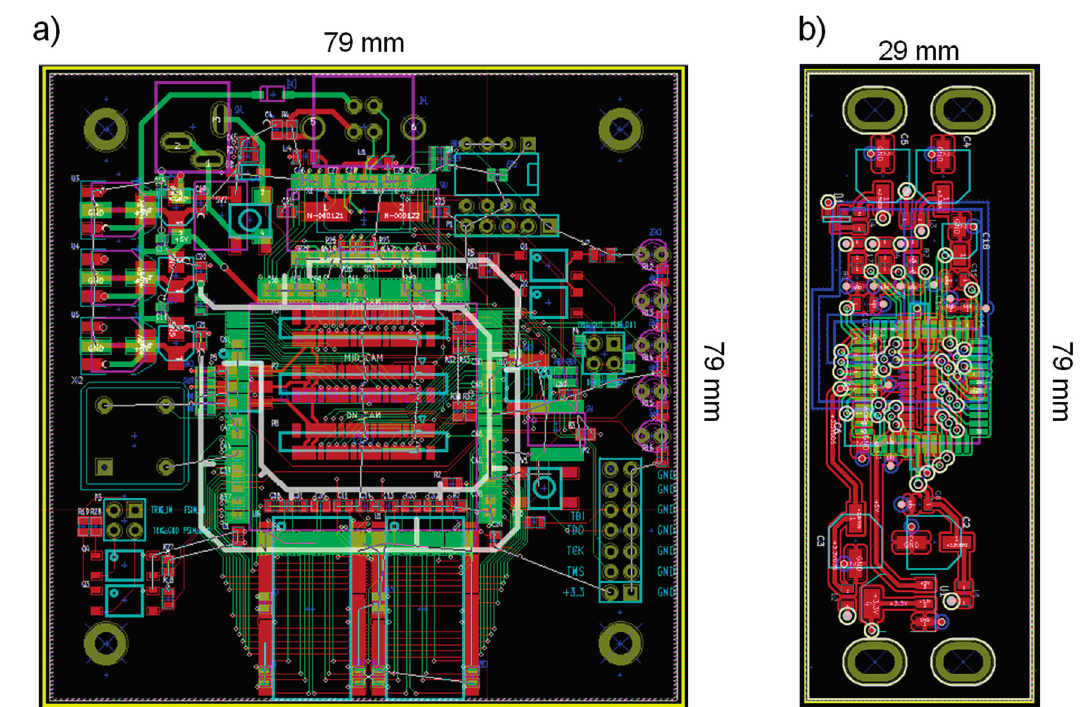
Figure 4. Gerber files for ( a ) main board containing FPGA, USB FIFO, two RAMs, and I2C multiplexer; and ( b ) CCD image